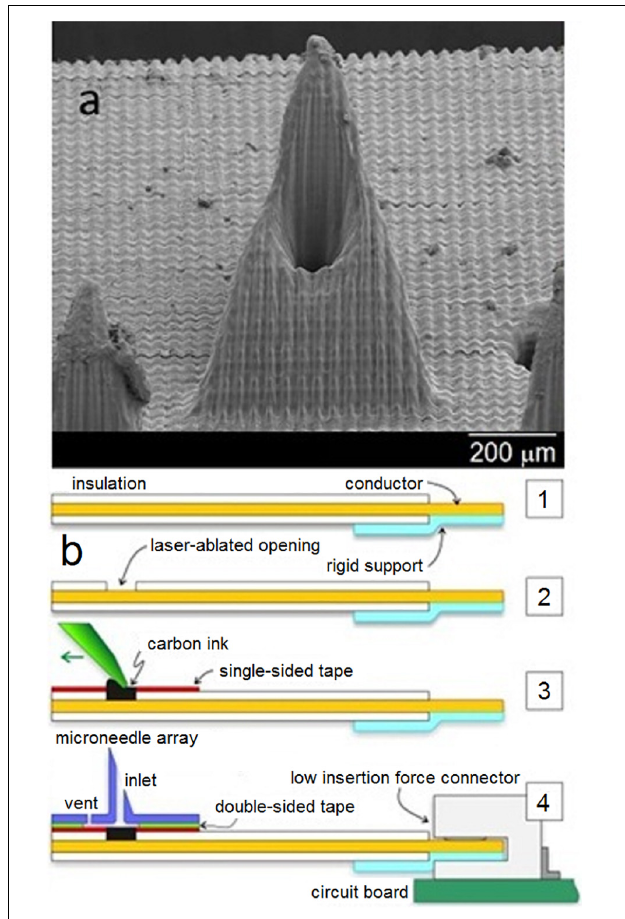
FIGURE 3 | Scanning electron micrograph of a single microneedle (a) and schematic of the microneedle-biosensor assembly (b) . Reprinted with permission from Miller et al.